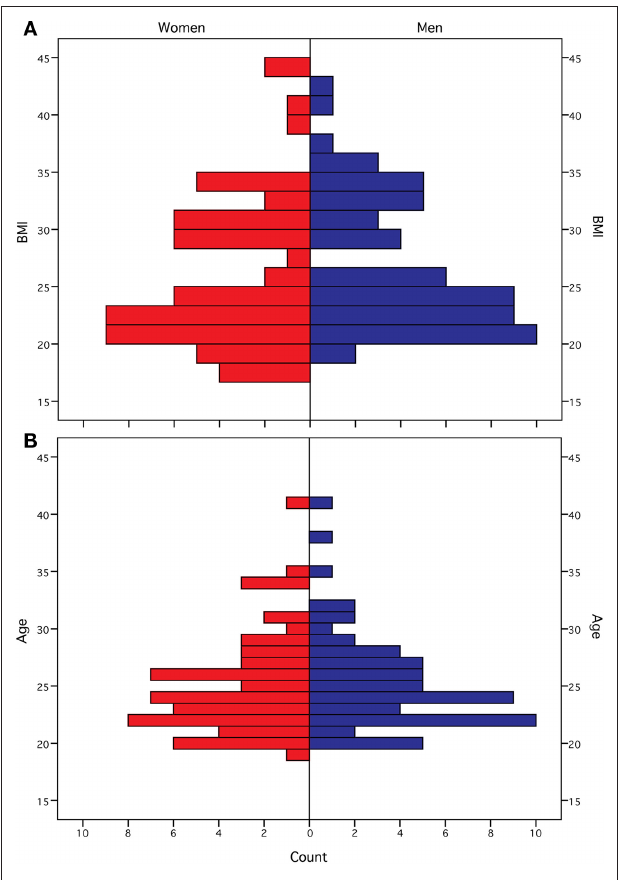
FIgure 1 | Distribution of body mass index [in kg/m 2 (A)] and age [in years (B)] for female and male